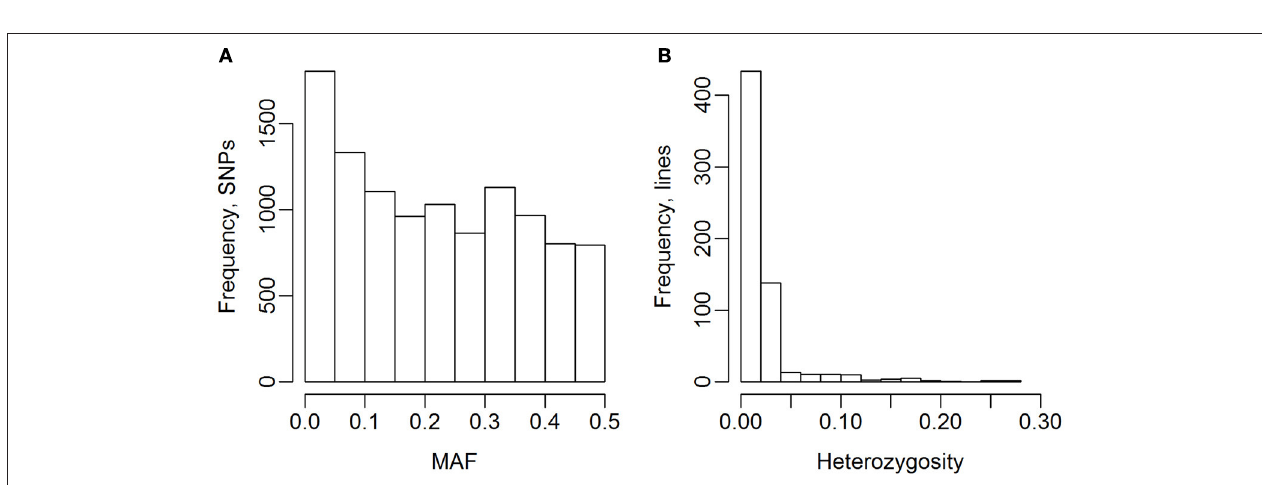
FIGURE 2 | Minor allele frequency (MAF) of SNPs and heterozygosity of lines. (A) MAF after selection of SNPs. (B) Heterozygosity of the 635 wheat lines.